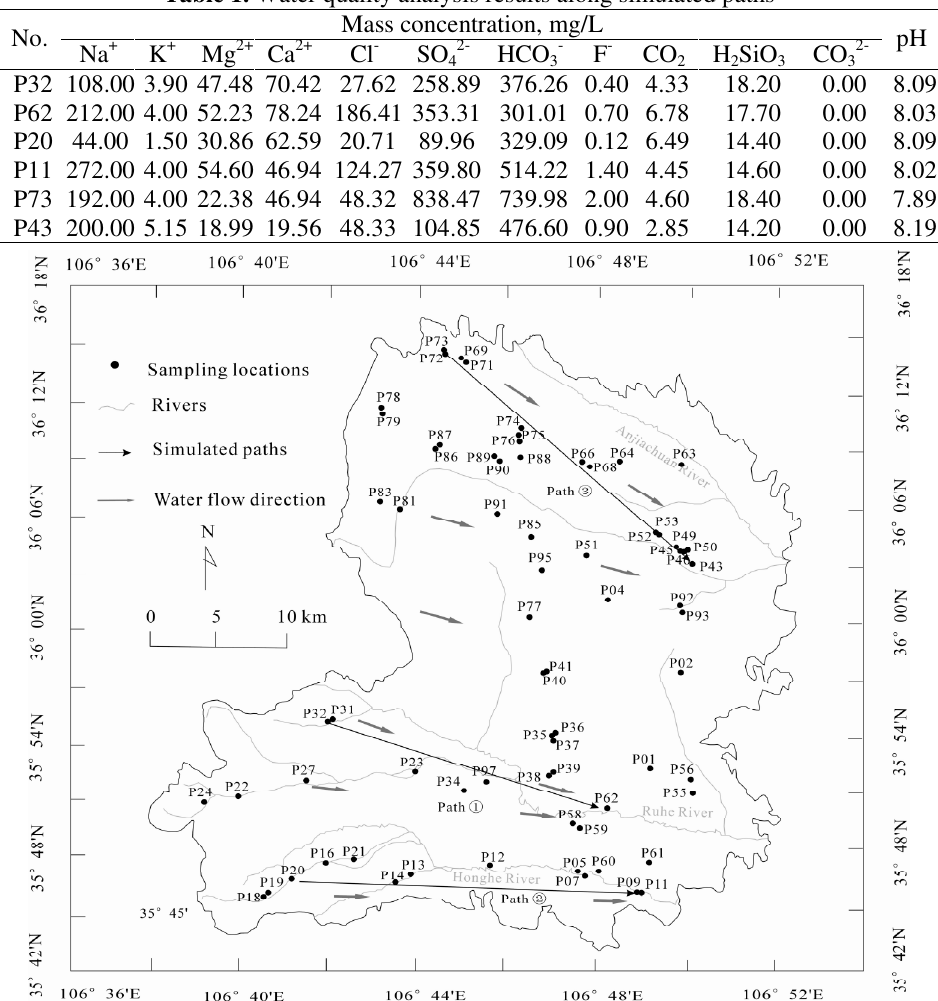
Figure 1. Sampling locations and simulated paths in study area Inverse geochemical